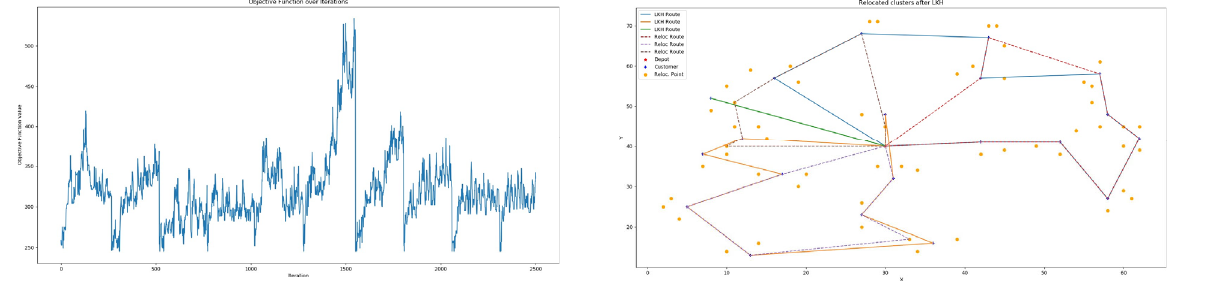
Fig. 8. Final solution of the algorithm without packing considerations (Instance